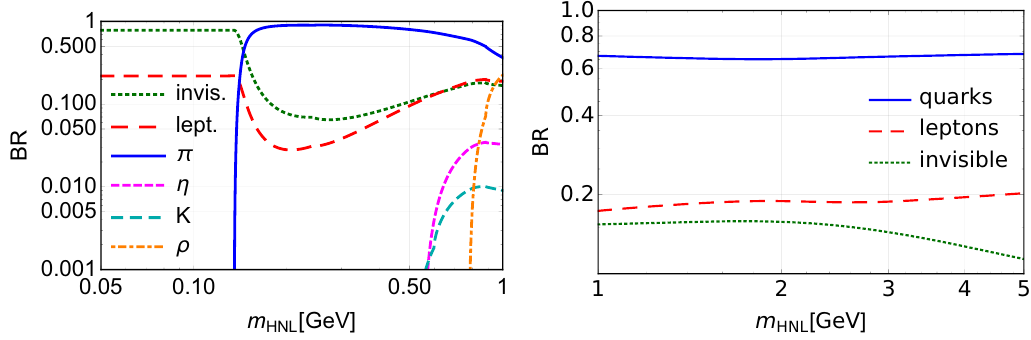
Figure 13 . The branching ratios of the HNL for the mixing ratio U e : U (cid:22) : U (cid:28) = 1 : 1 : 1. Left panel: region of masses below 1 GeV; Right panel: region of masses above 1 GeV, for quarks the QCD corrections (3.10), (3.11) are taken into